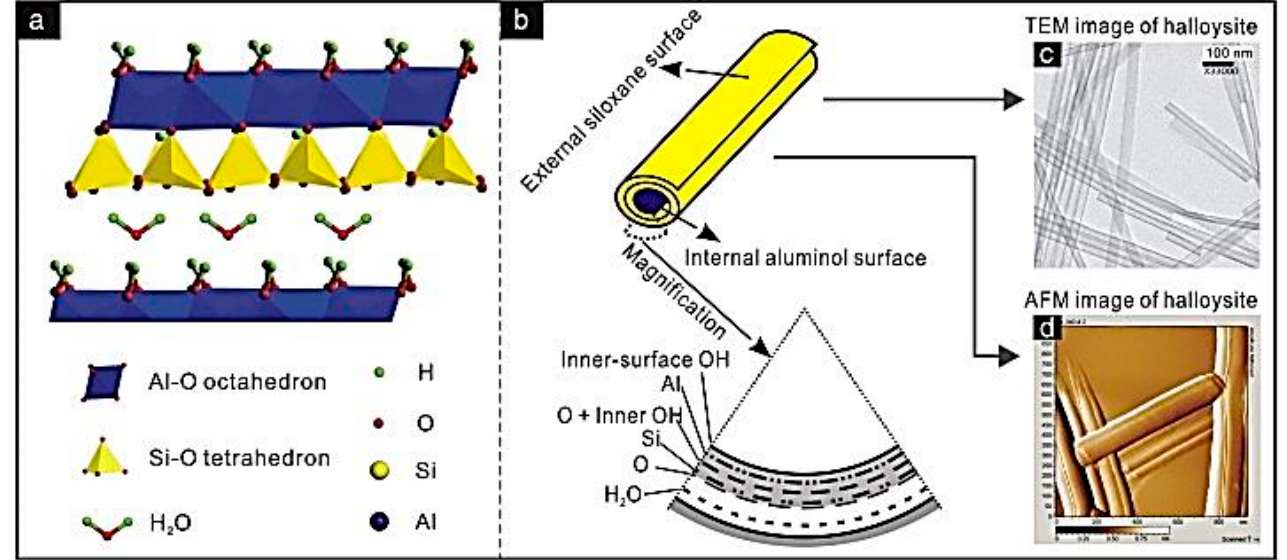
Figure 1. Schematic diagram of ( a ) the crystalline structure of Hal-(10 Å), ( b ) the structure of Hal particle, ( c – d ) TEM and AFM images of Hal. [10].